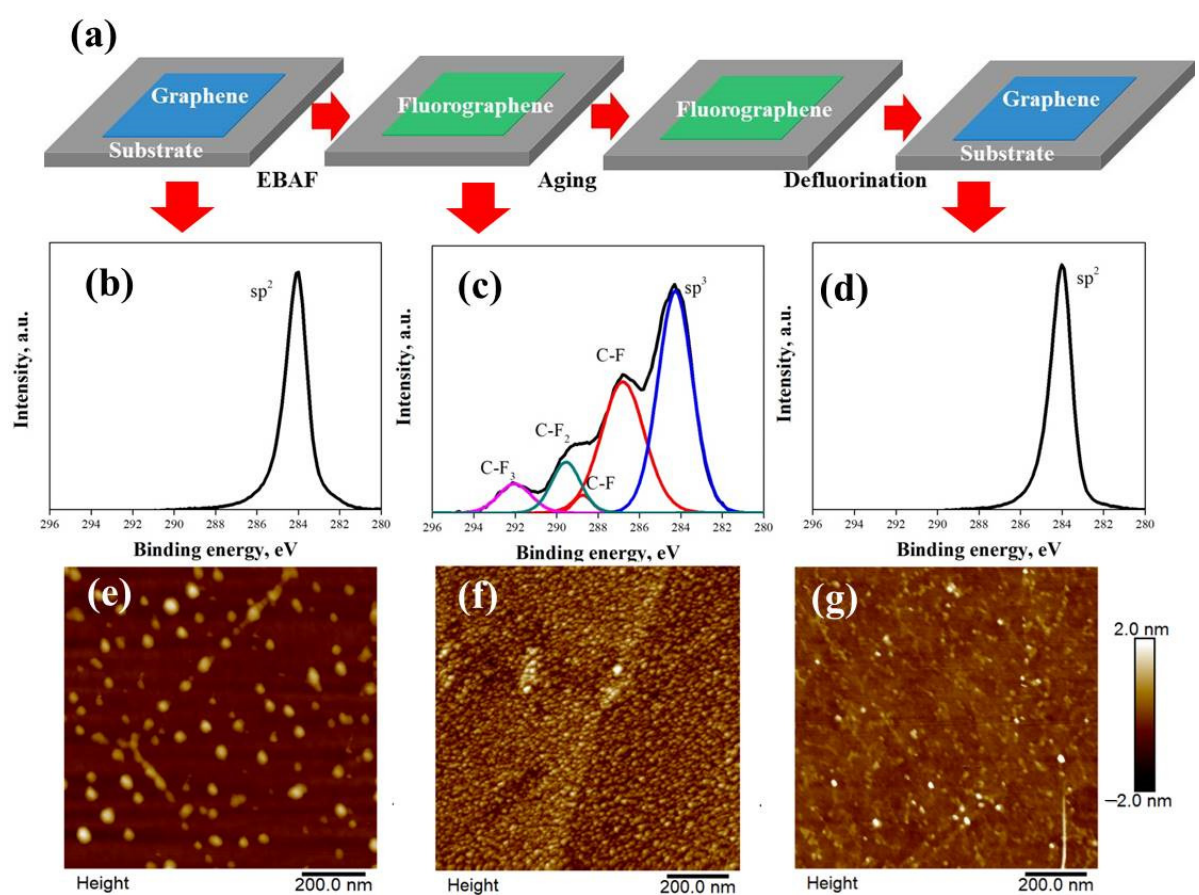
Figure 2. ( a ) Illustration figure of the fluorination/defluorination cycle on graphene. The C1s core level spectra at different steps are shown in ( b − d ), corresponding to the initial graphene, fluorinated graphene, and defluorinated graphene, respectively. ( e − g ) on the right show the height contrast AFM images, corresponding to the graphene at different fluorination/defluorination cycles.